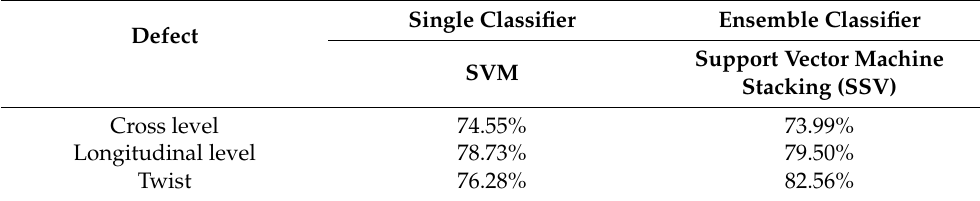
Figure 6. Structure of ensemble classifiers. Adapted from [99]. Table 8. Overall accuracy results of single and ensemble models. Adapted from